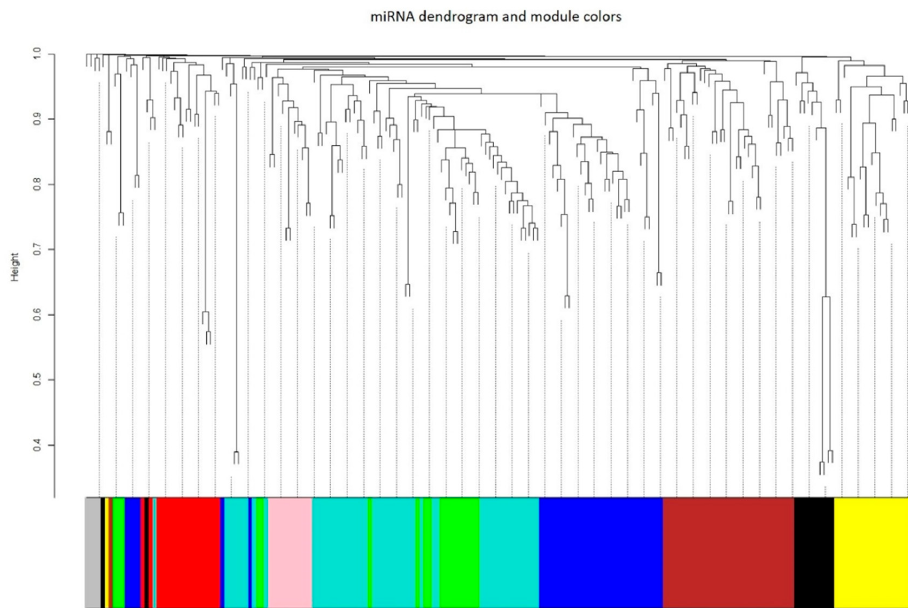
Figure 3. Exosomal miRNA co-expression network analysis by WGCNA. Hierarchical cluster dendrogram of the 207 identified exosomal miRNAs. Modules corresponding to branches are labeled with colors indicated by the color bands underneath the tree. Number in each cell shows the correlation of the corresponding module eigengene and spontaneous lung cancer susceptibility, with the p -value printed below the correlation. The cell color was coded by correlation according to the color legend.